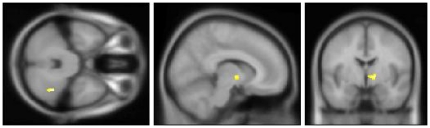
TGI versus cold and warm.Crosshair position: x = 10 mm, y = −3 mm, z = −32 mm. This corroborated the TGI-related activation in the right thalamus. Additionally, activation was observed in the right hippocampal formation (not shown) as well as in the right cerebellum. See also Table 4.